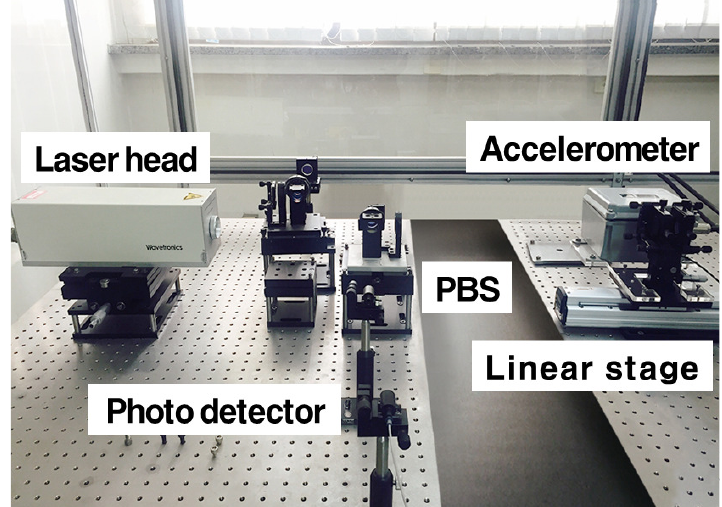
Figure 2. Seismic wave measurement system using a laser